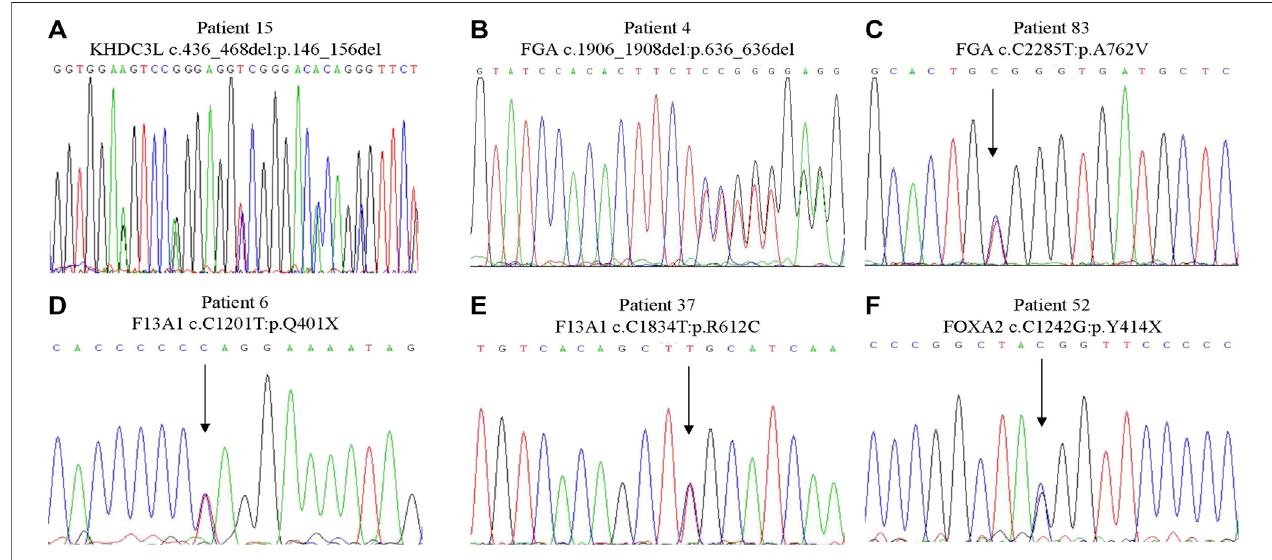
FIGURE2| Sangersequencingofthevariantsinstrongcandidategenes. (A) KHDC3Lc.436_468del:p.146_156del. (B) FGAc.1906_1908del:p.636_636del. (C) FGA c.C2285T:p.A762V. (D) F13A1 c.C1201T:p.Q401X. (E) F13A1 c.C1834T:p.R612C. (F) FOXA2 c.C1242G:p.Y414X.